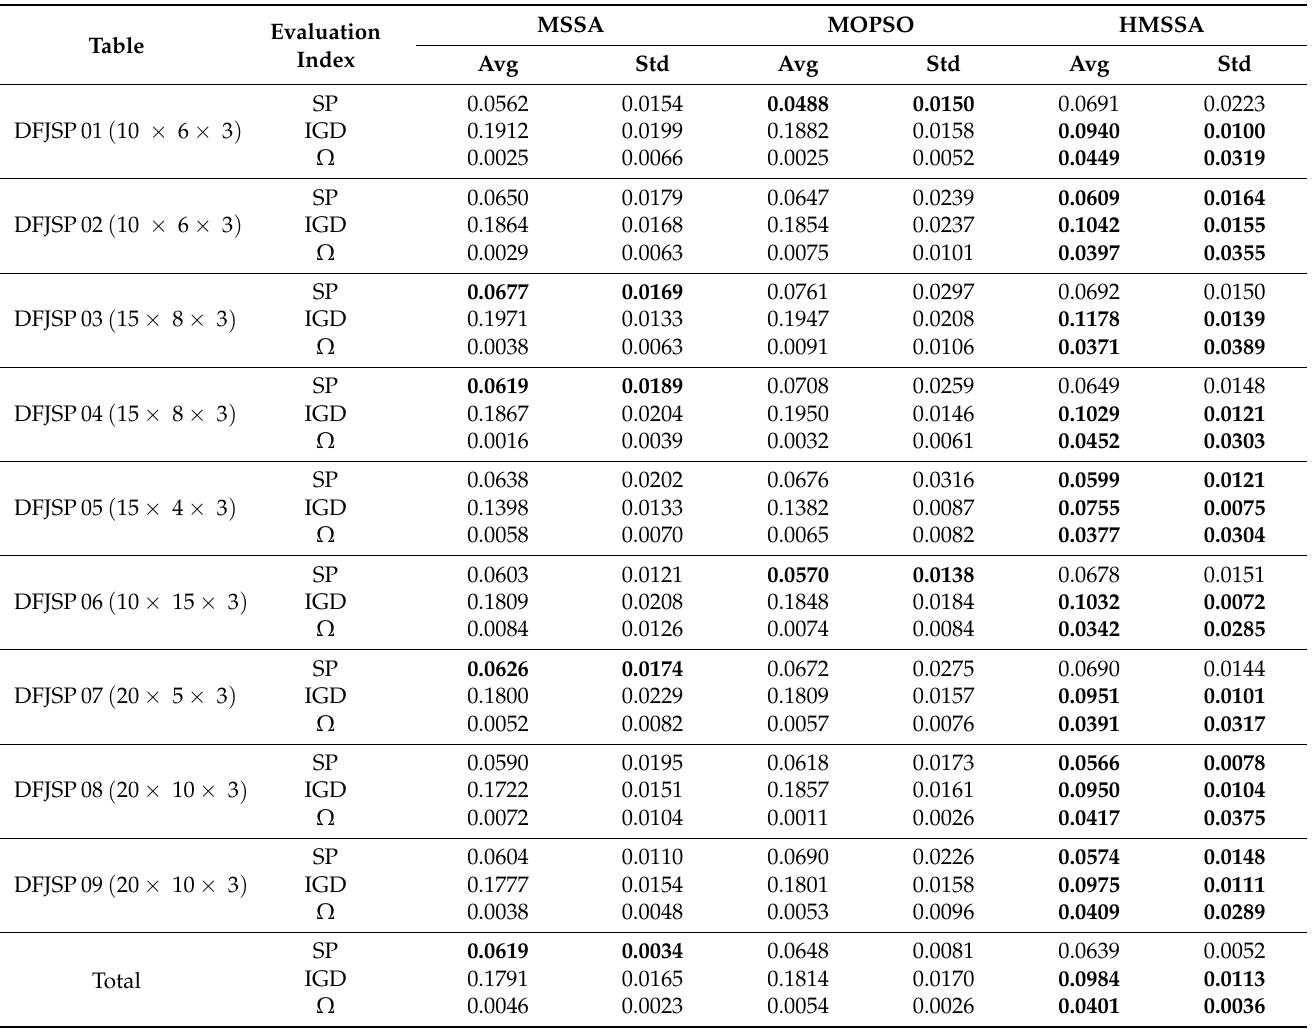
Table 4. Simulation test results of three